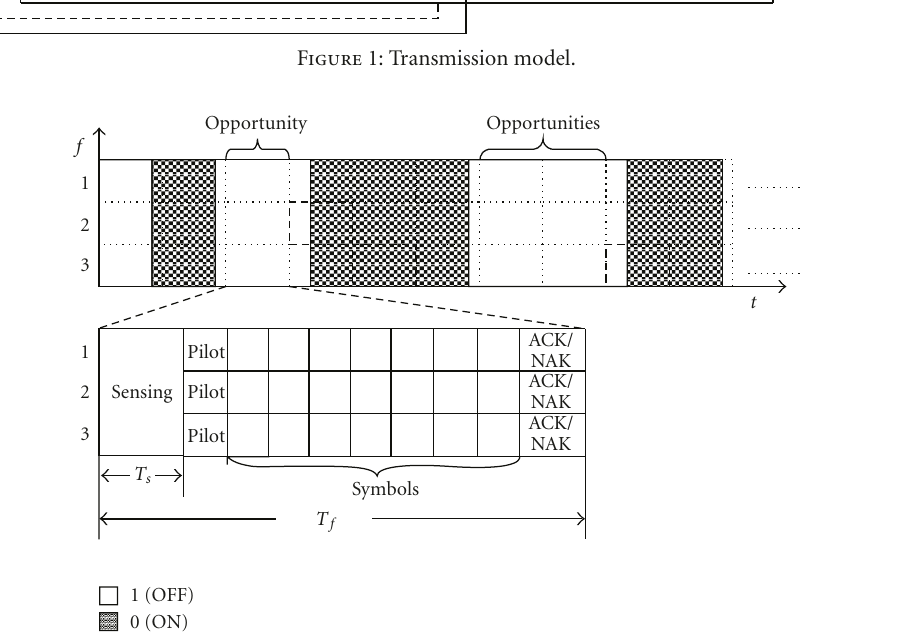
Figure 2: Frame structure, M =